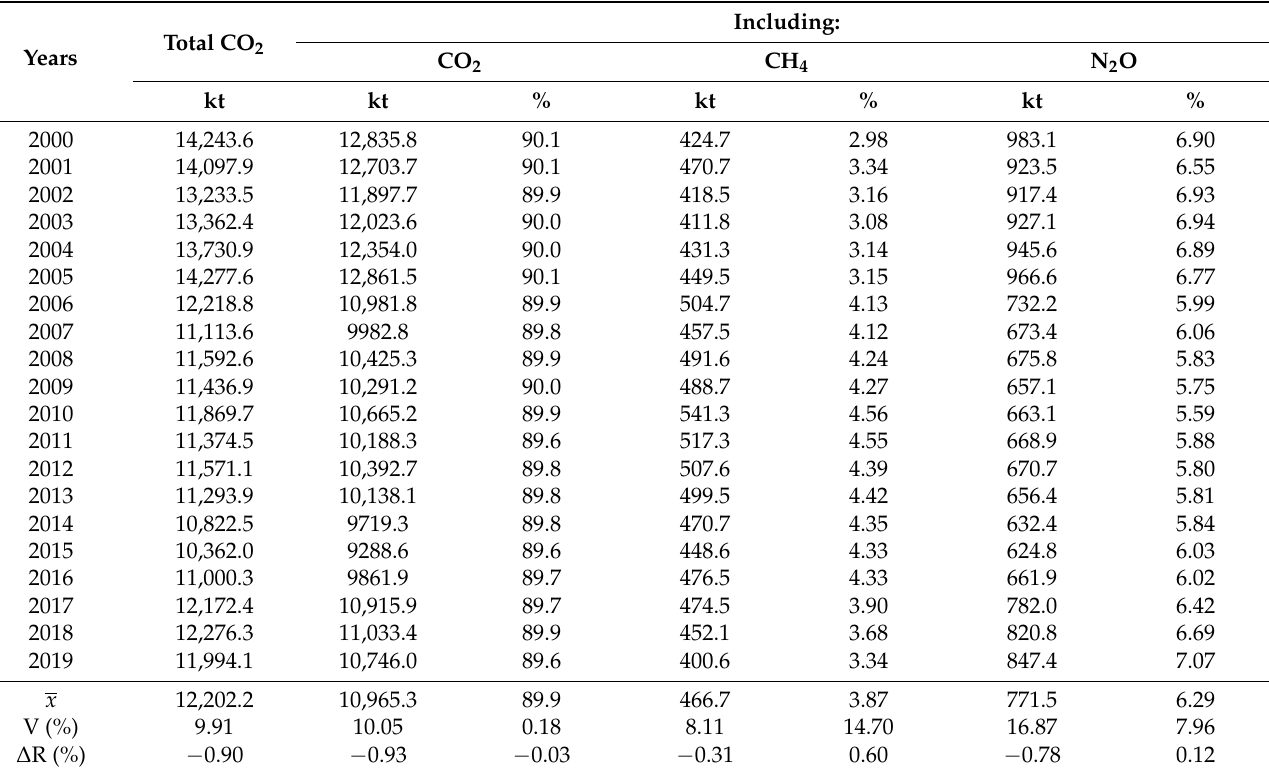
Table 2. The amount and structure of emissions from energy consumption in Polish agriculture in 2000–2019 (CO 2 equivalent, kt—thousand tons) 1 .